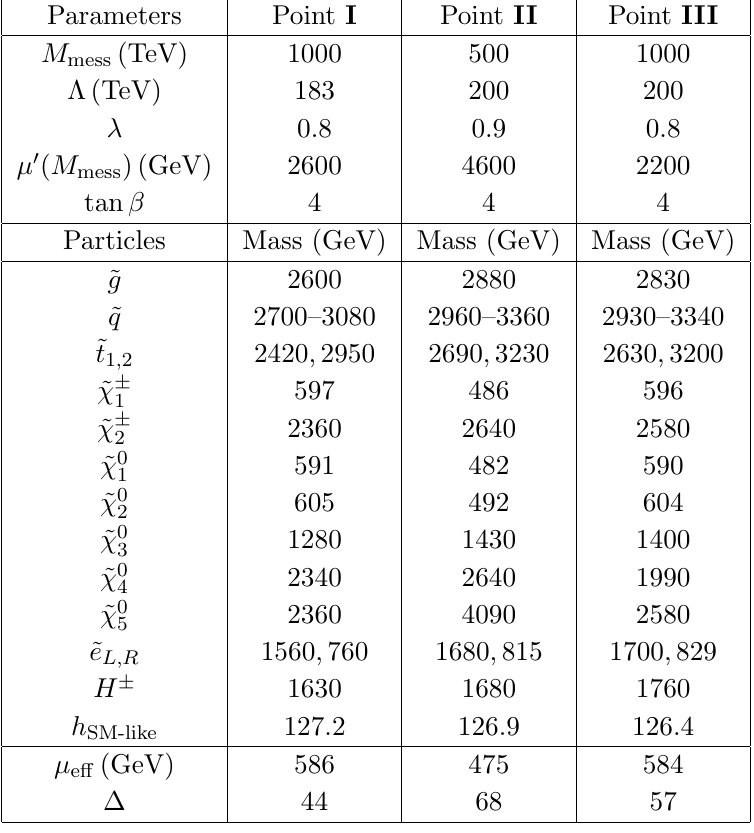
Table 1 . Mass spectra in sample points. Here, (cid:22) e(cid:11) = (cid:21) h S i